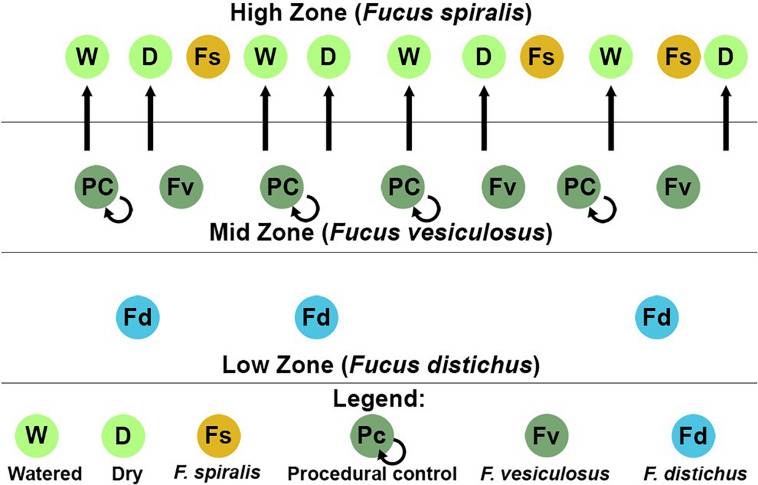
Sampling scheme for both the natural survey and transplant experiment in one of the two study areas at Schoodic Point, Maine (United States). Dry (D), procedural control (PC), and watered (W) refer to our transplant treatments for Fucus vesiculosus.